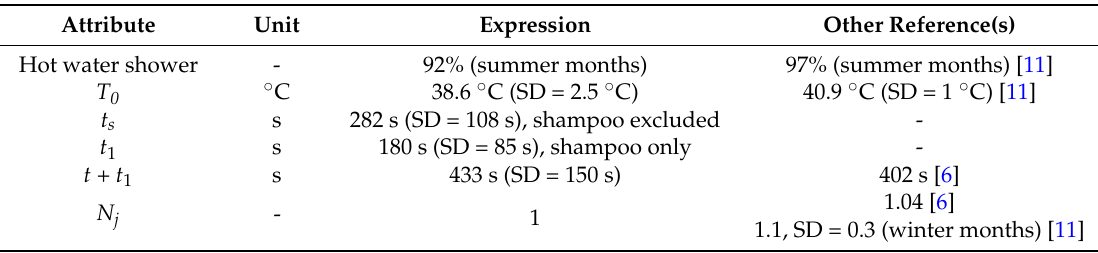
Table 1. Surveyed showering